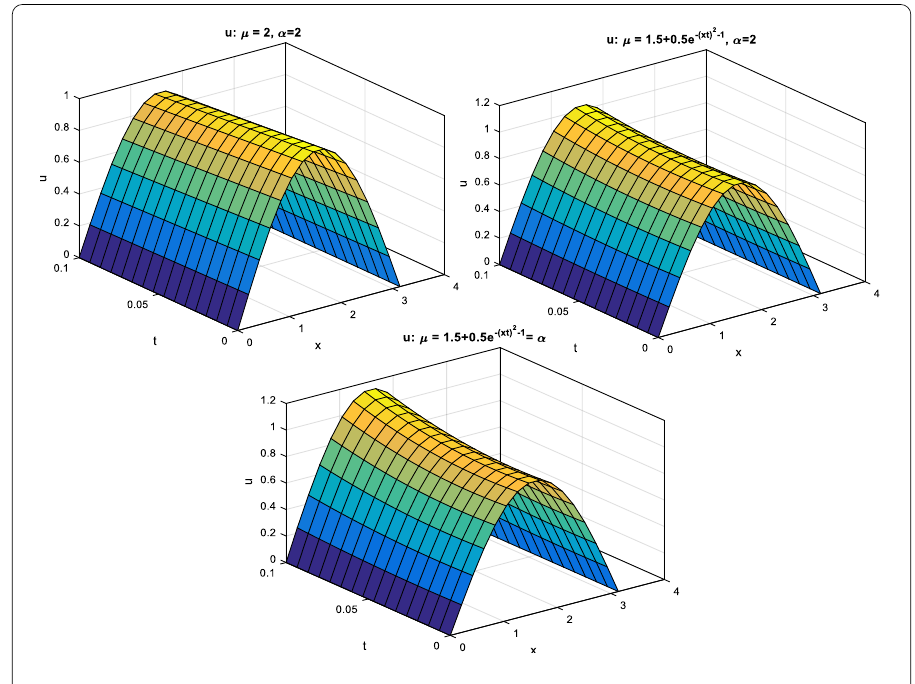
Figure 4 Comparison of the approximate solutions utilizing the introduced method in Example 2 for different values of μ , α